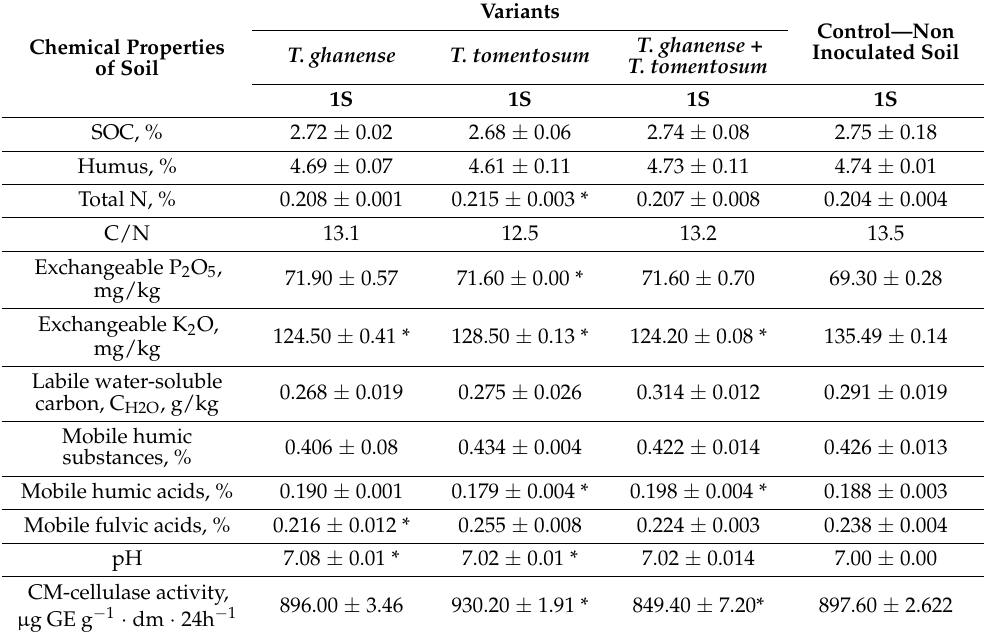
Table 5. The chemical properties of grassland 1S after 14 days of inoculation. Numbers followed by “*” indicate significant differences ( p < 0.05).